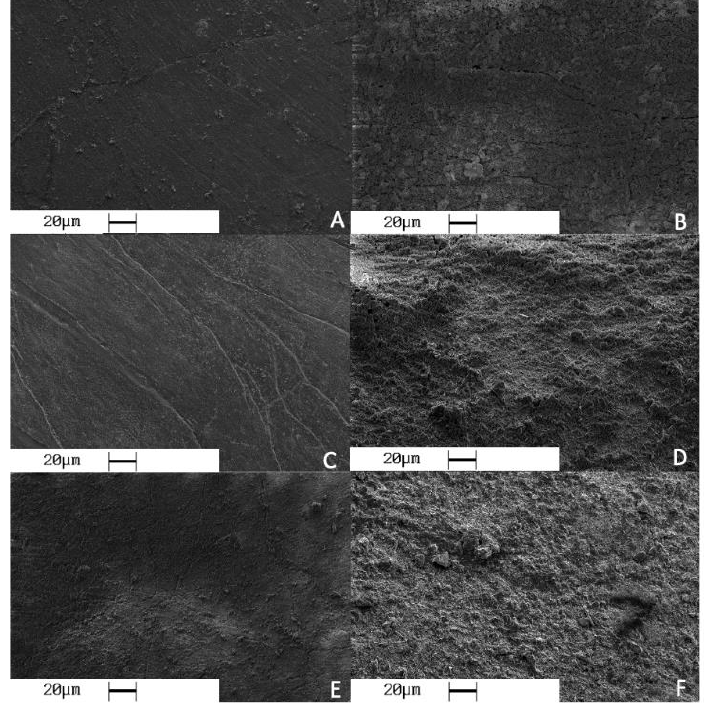
Figure 4. SEM observations: ( A ) intact and polished enamel; ( B ) enamel subjected to acid attack; ( C ) enamel treated with toothpaste A; ( D ) enamel treated with toothpaste A and second acid attack; ( E ) enamel treated with toothpaste B; ( F ) enamel treated with toothpaste B and second acid attack.